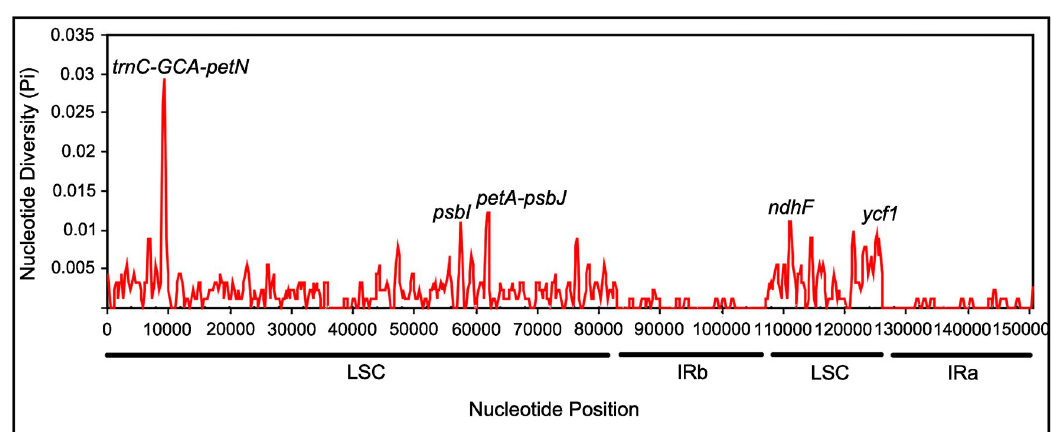
Fig 7. Sliding window analysis of the cp genomes of three Carpesium